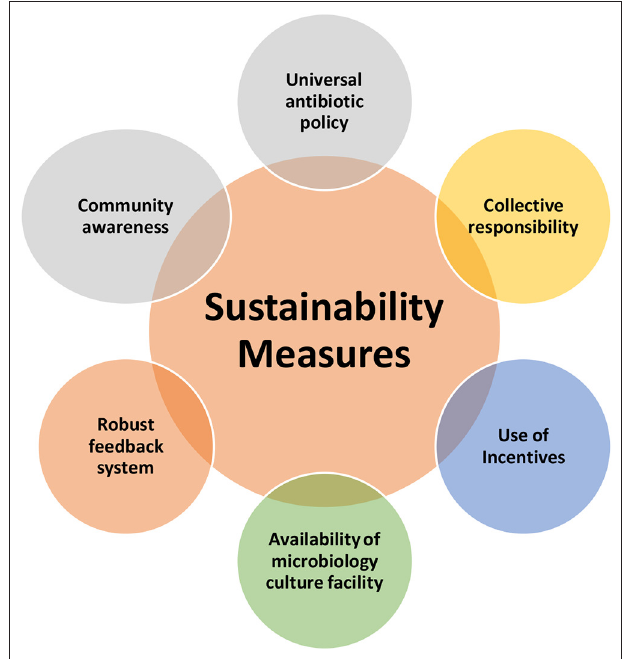
FIGURE 4 | Sustainability measures for antimicrobial stewardship